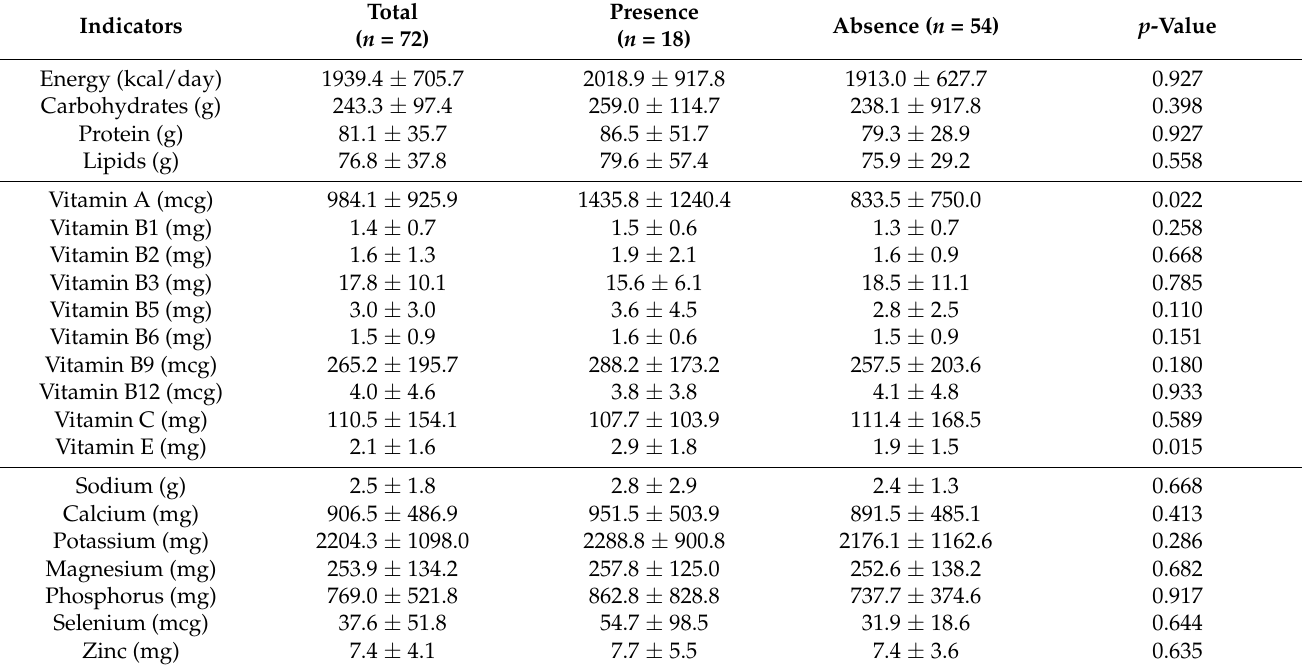
Table A5. Dietary characteristics regarding abdominal obesity.